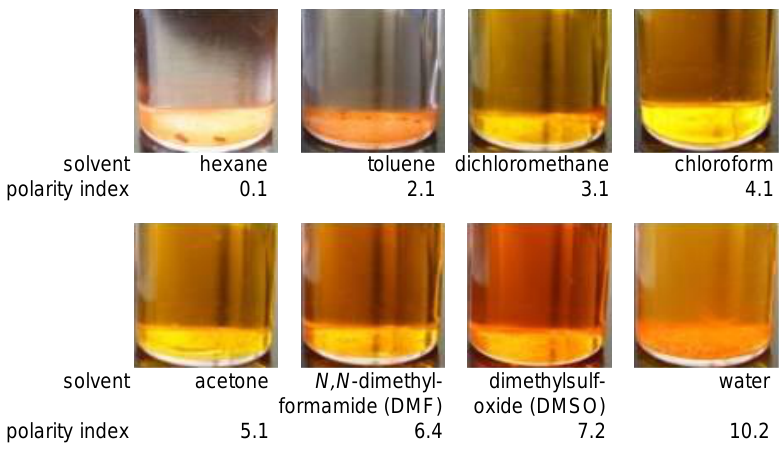
Figure 2. List of dipping solvents and photographs of bathophen ruthenium in these